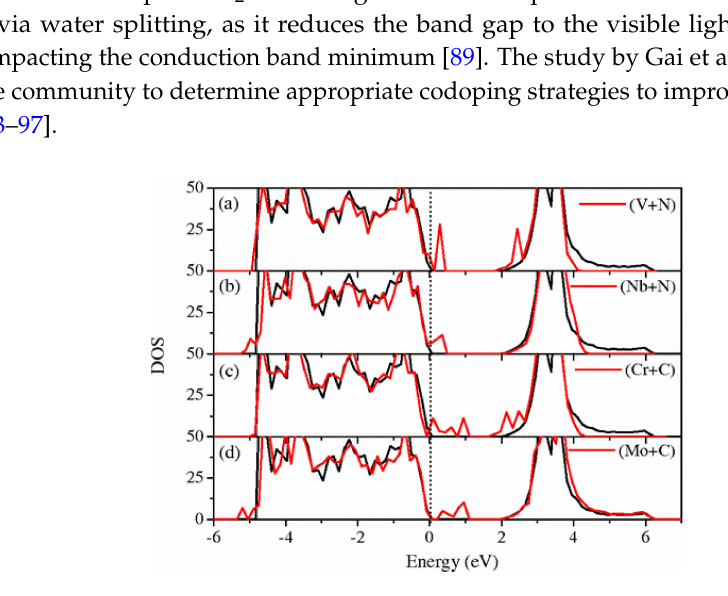
Figure 10. Density of states results of undoped TiO 2 and codoped-TiO 2 . Reproduced with permission from [89]. American Physical Society,